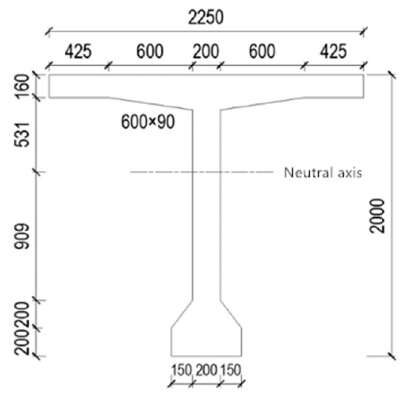
Figure 2. Sketch map of T-beam.